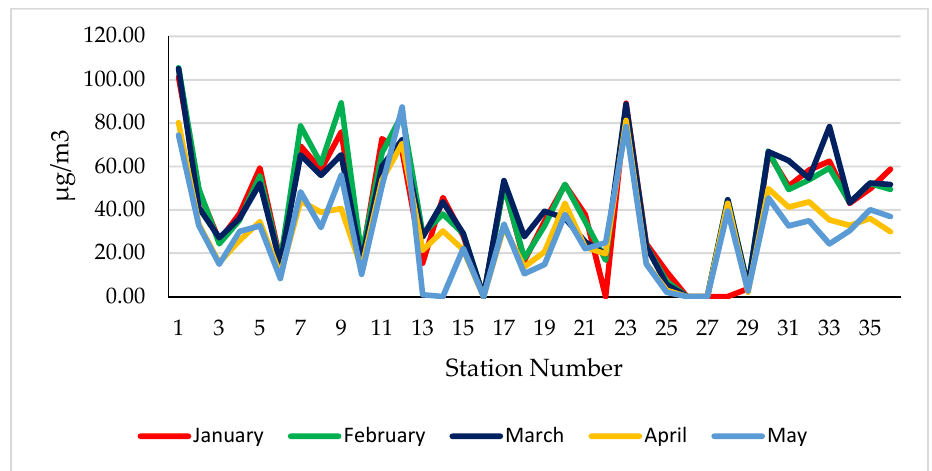
Figure 5. Change of NO 2 parameter according to months [53]